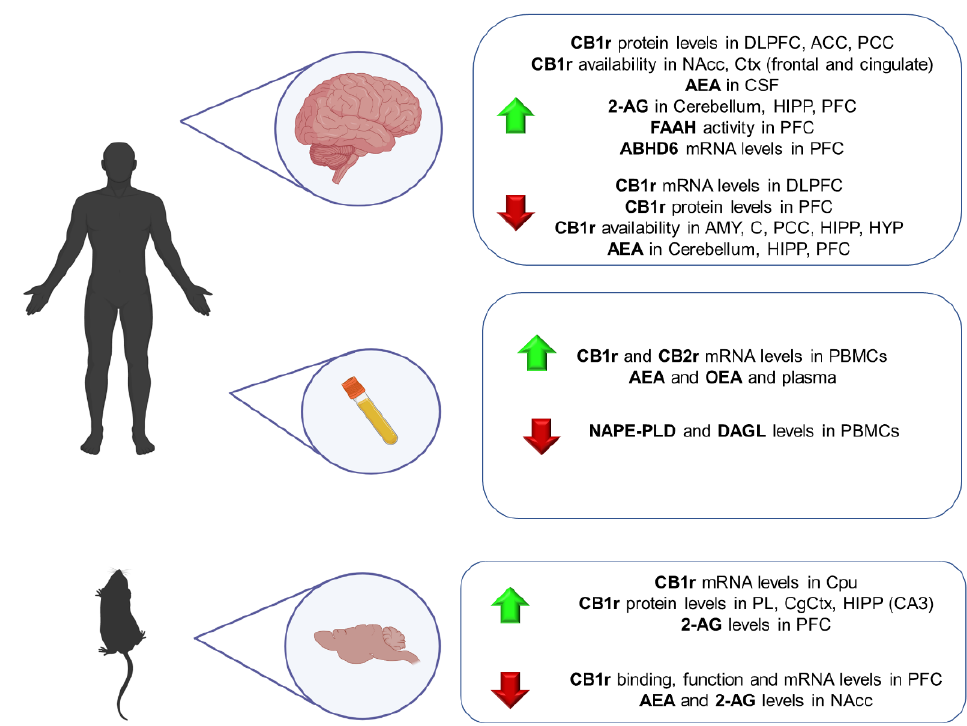
Figure 4. Main findings regarding the alterations of the ECS components in animal models and patients with schizophrenia. 2-AG: 2-arachidonoylglycerol; ACC: anterior cingulate cortex; AEA: anandamide; AMY: amygdala; CB1r: cannabinoid receptor 1; CB2r: cannabinoid receptor 2; Ctx: